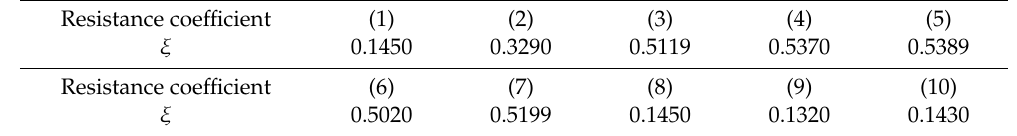
Table 1. Coe ffi cient of local resistance loss shown in Figure